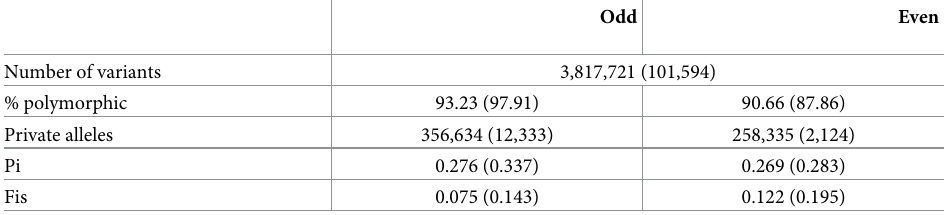
Table 2. Population metrics of the two lineages.